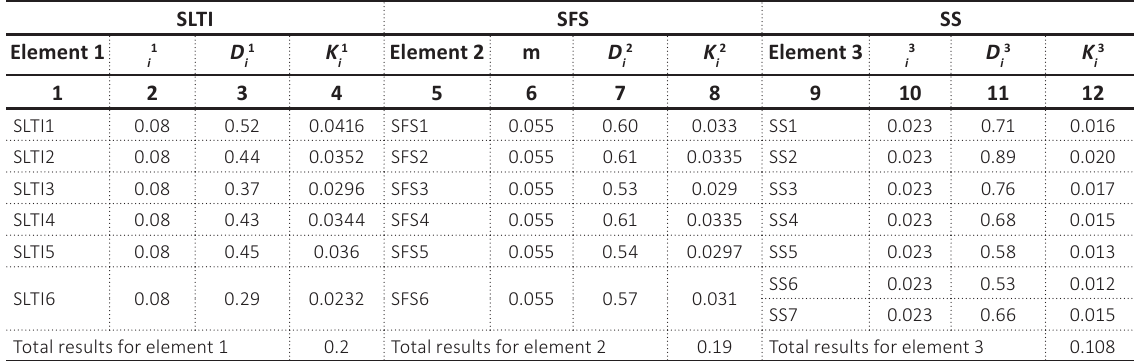
Table 7. Assessment of the level of SLTI, SFS, and SS through weighted means SLTI SFS SS Element 1 i